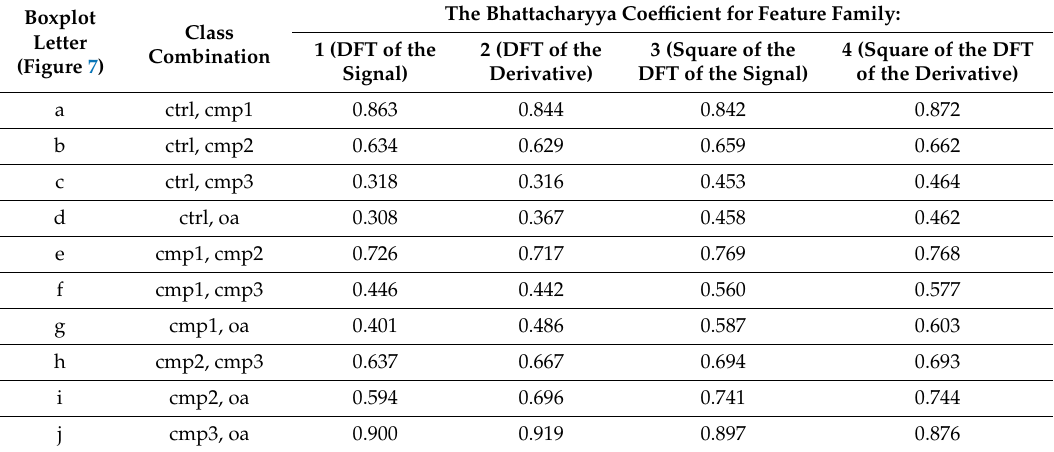
Table 1. Research results: the Bhattacharyya coe ffi cients, for best frequency range, for each feature family, for each class combination. Corresponding frequency ranges are presented in Table 2.